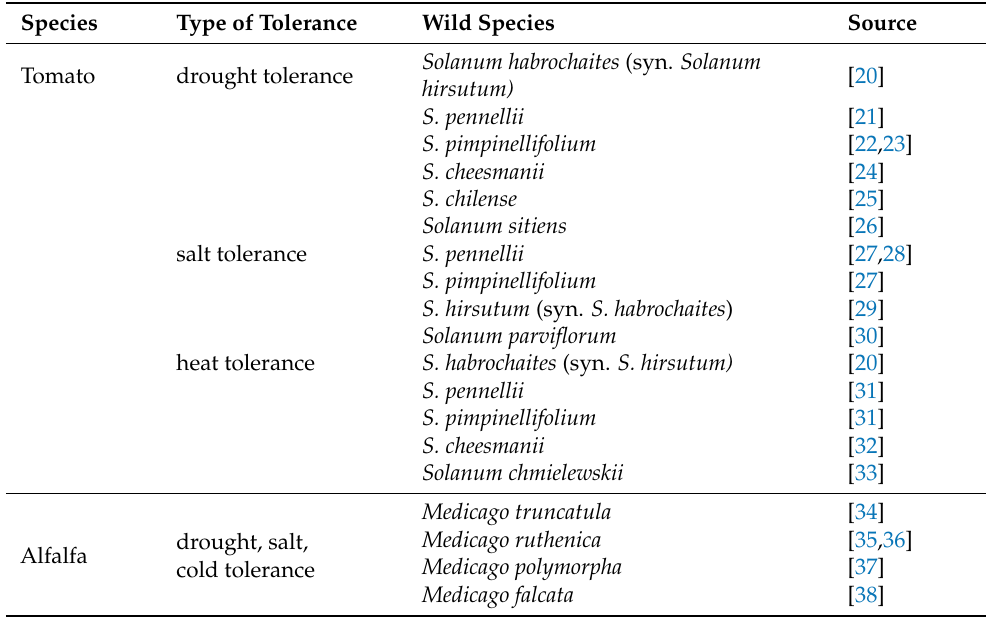
Table 1. Crop wild relatives (CWRs) of the respective crop genera that present tolerance to abiotic stresses.